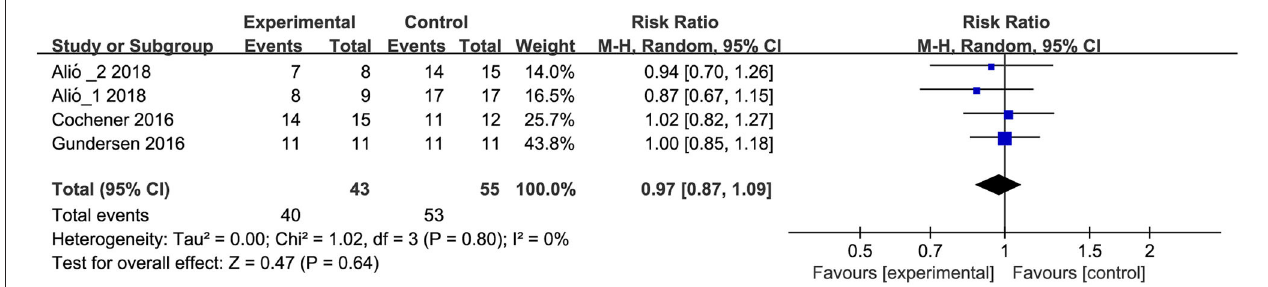
FIGURE 6 | Meta-analysis of patient’s satisfaction between trifocal and bifocal IOLs. M-H, Mantel-Haenszel; CI, confidence interval. Experimental and control indicate trifocal and bifocal IOLs,